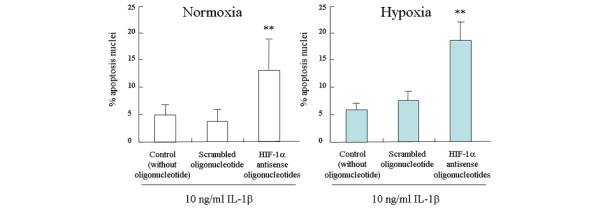
Apoptosis induction in HIF-1α-deficient chondrocytes. IL-1β was used for apoptosis induction under hypoxic or normoxic conditions in chondrocytes lacking hypoxia-inducible factor 1α (HIF-1α), treated with oligonucleotide, and cultured without oligonucleotide, and also not exposed to the oligonucleotide or HIF-1α antisense nucleotides. IL-1β-induced apoptosis was significantly increased in HIF-1α-deficient chondrocytes compared with chondrocytes treated with scrambled oligonucleotide under both normoxic and hypoxic culture conditions. Statistical differences were calculated using data from four independent experiments. **P < 0.01, control oligonucleotide group vs HIF-1α-antisense group.